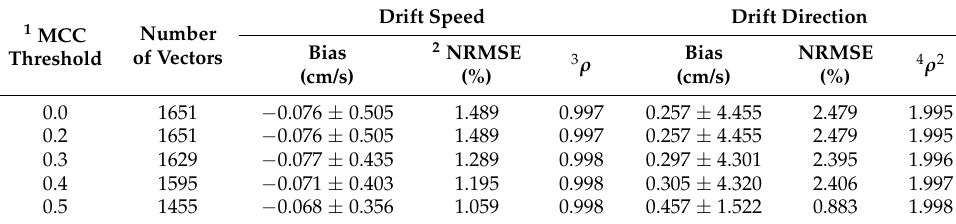
Figure 7. Comparison of the drift vectors derived from the cross-sensor (KOMPSAT-5 and COSMO-SkyMed) and SVP buoys. ( a ) Scatter plot of the drift speed. Black line is the identity and regression line, and the color represents maximum cross correlation of the pattern matching result. ( b ) Histogram of the difference in drift direction. The y -axis is in log scale. Table 4. Accuracy evaluation results of the cross-sensor-derived sea ice drift vectors.